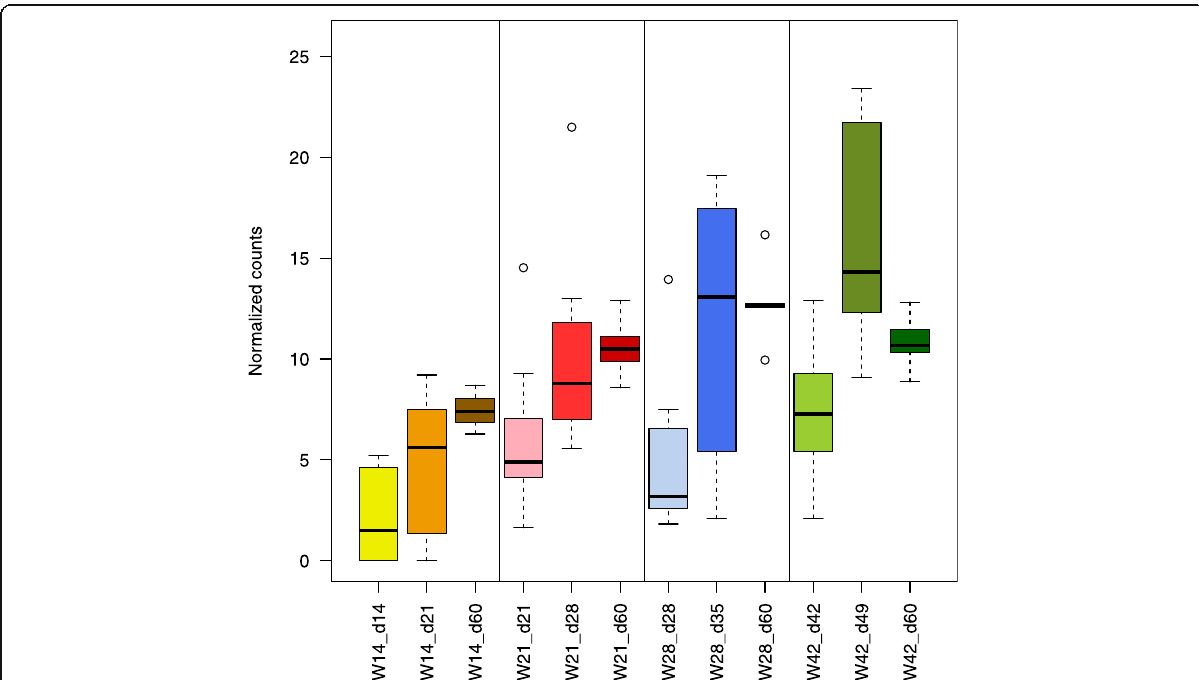
Fig. 5 Abundance of F. prausnitzii at each sampling point for piglets weaned at 14 days of age (W14), 21 days of age (W21), 28 days of age (W28), and 42 days of age (W42). The normalized abundances of the three OTUs annotated as F. prausnitzii (OTU IDs 851,865, 350,121, and 25,215) were summed for each individual